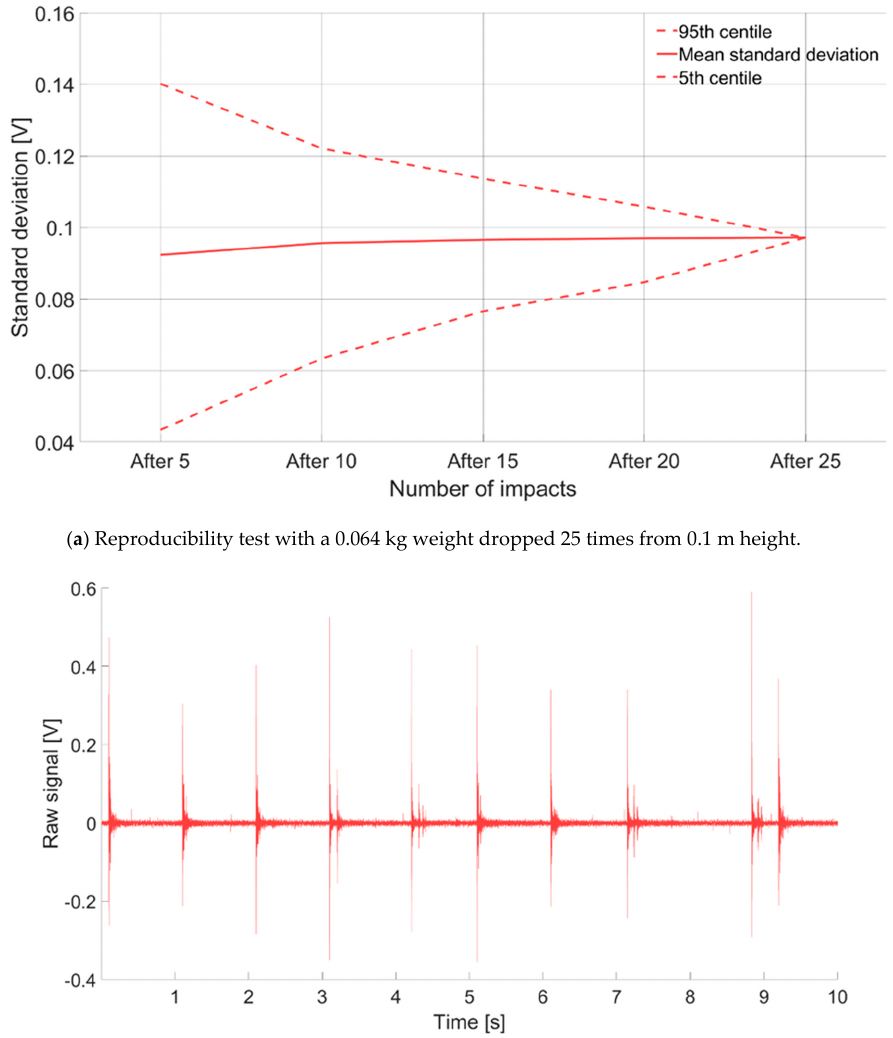
Figure 2. ( a ) Reproducibility test conducted in the VAW laboratory with a weight of 0.064 kg dropped 25 times from a 0.1 m height, the graph shows the standard deviation of maximum amplitudes as function of cumulative number of tests calculated in 5 million random combinations; ( b ) voltage associated to 10 impacts induced by a 0.064 kg weight dropped from a 0.1 m height. The maximum positive amplitude (V) is recorded for each impact.